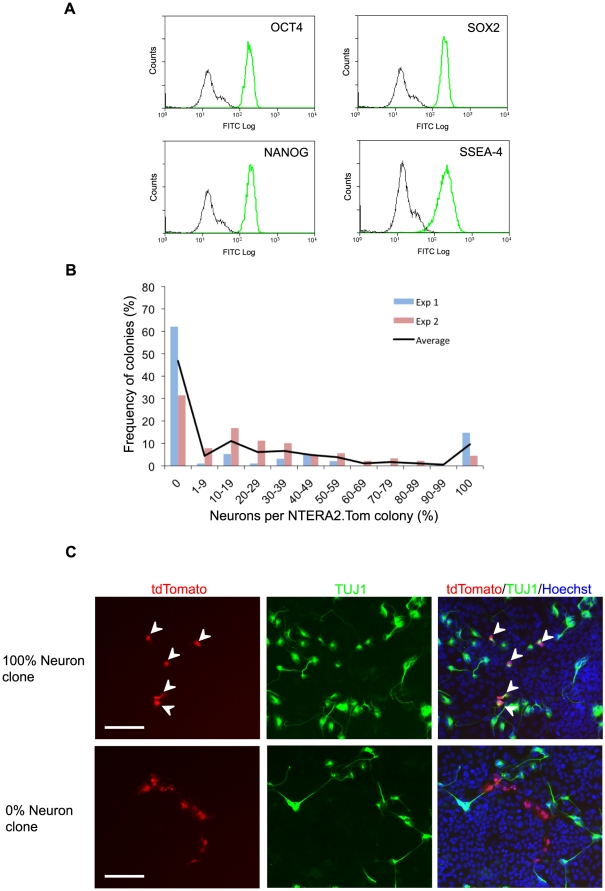
Differentiation Characteristics of Individual Stem Cells.(A) Flow cytometric analysis of undifferentiated stem cell markers in the clonal NTERA2.Tom cell line. Black line depicts P3X negative control and green depicts antigen specific expression (OCT4, SOX2, NANOG and SSEA4). (B) Graph depicting the percentage of TUJ1 positive neurons within differentiated colonies derived from individual RA treated NTERA2.Tom stem cells. (C) Images of differentiated NTERA2.Tom colonies derived from individual NTERA2.Tom cells on a background of wildtype NTERA2 cells. Cell were exposed to RA for 21 days (Green - βIII tubulin, Blue - Hoechst) White arrows depict βIII tubulin positive NTERA2.Tom neurons. Scale bar represents 50 µM.